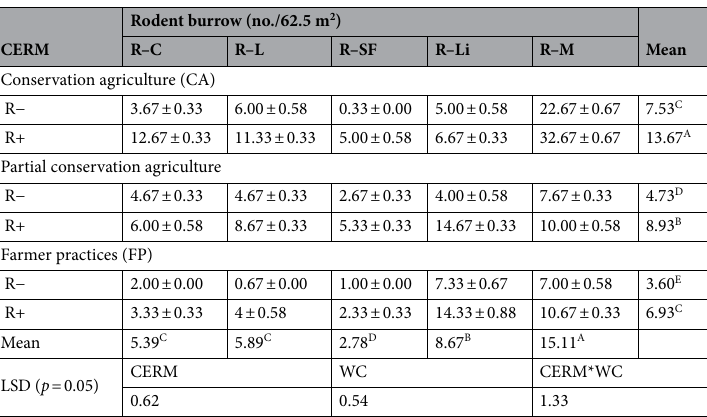
Table 4. Burrows of bandicoot rats, B. bengalensis as influenced by different crop establishment-cum- residue management (CERM) and winter crops in rice-fallow system of eastern India (after 5th years of